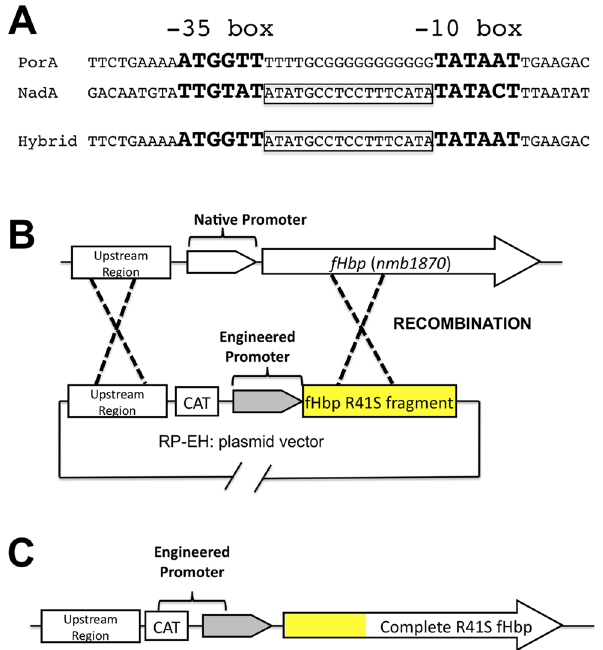
Figure 1. Schematic representation of the genetic strategy to over-express fHbp ID 9 R41S. Panel A: Sequences of natural porA and nadA promoters and the engineered (Hybrid) promoter where the sequence between the 2 10 and 2 35 boxes of the porA promoter containing the poly G tract was replaced with the sequence from the Neisserial nadA promoter to eliminate slip-strand miss-pairing. Al- though not shown, in the hybrid promoter the porA promoter sequence ( 2 164 to 2 35 and 2 10 to + 57) was left intact. Panels B-C: Strategy for replacement of the native fHbp promoter by the engineered promoter sequence, and introduction of the R41S mutation in fHbp to decrease fH binding (see text for additional details). Panel B shows the genomic environment of the fHbp gene ( nmb1870 ) and the plasmid RP-EH used. CAT, represents the chloramphenicol resistance cassette used for selection of the recombinants. The yellow R41S box represents the first 255 base pairs of the fHbp ID 9 gene containing the mutation that leads to the R41S change in the mature mutant ID 9 fHbp. Panel C represents the organization of the region after the recombination.